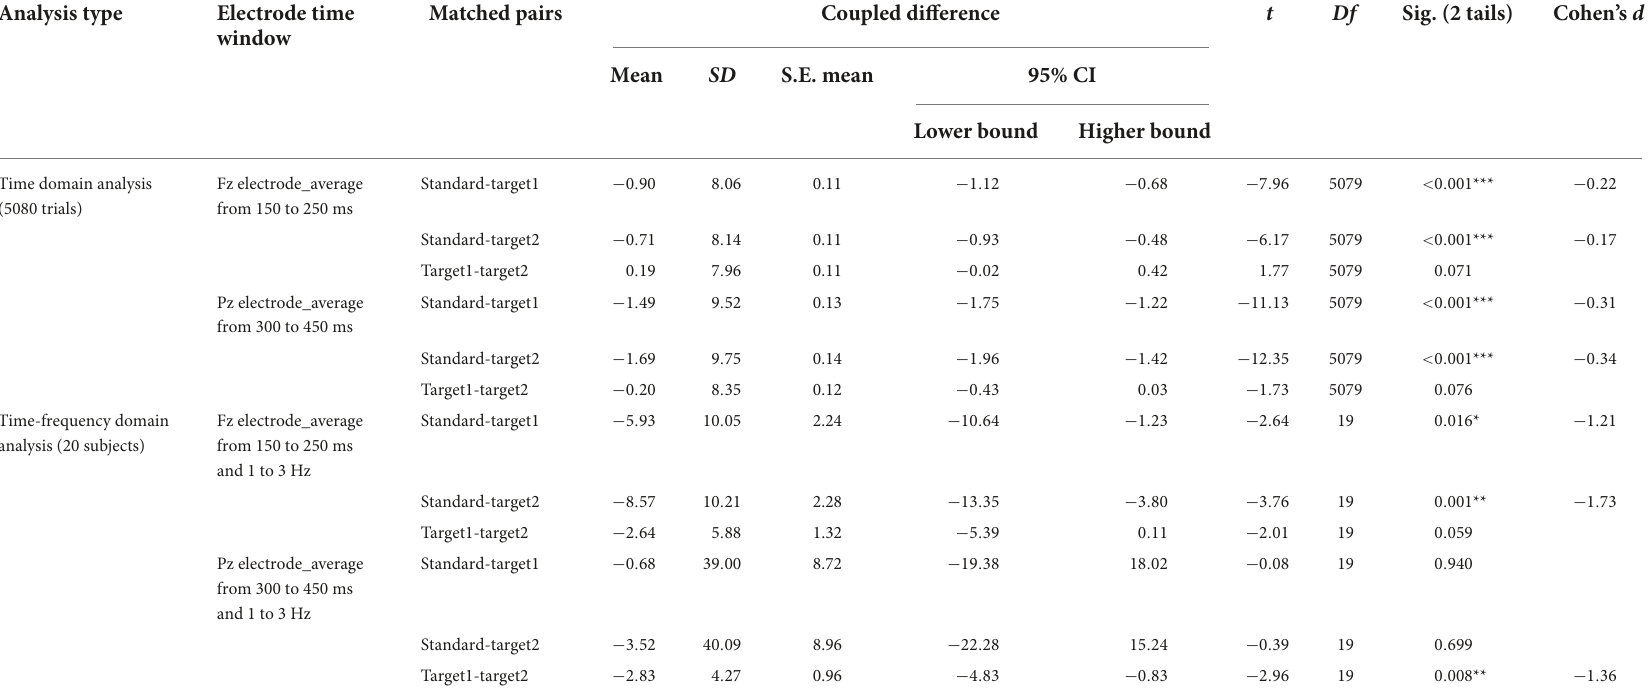
TABLE 1 The paired t -test results for the time domain analysis and the time-frequency domain